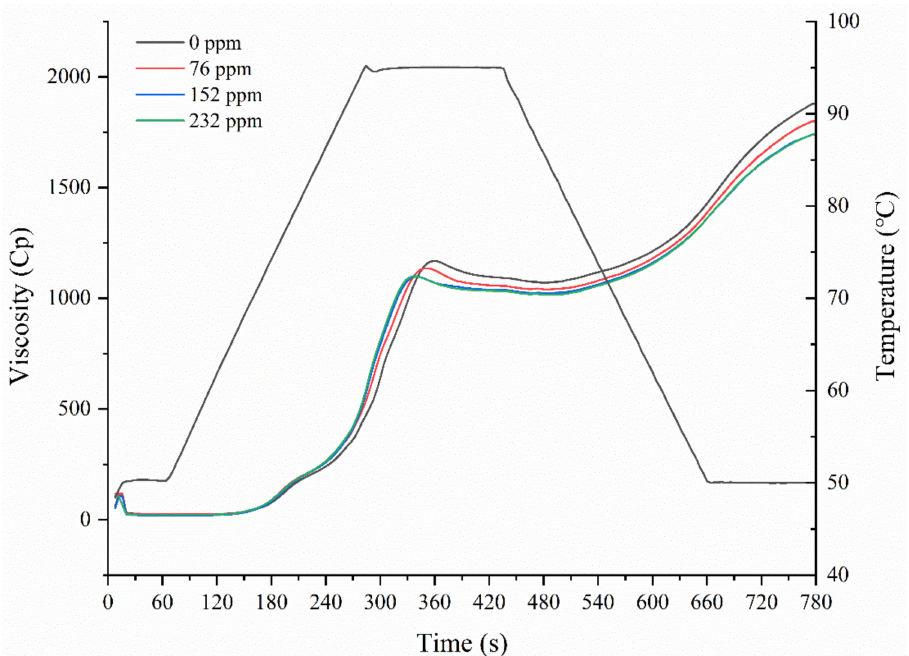
Figure 1. RVA pasting curves of buckwheat-based composite flour treated by gas chlorine dioxide at different